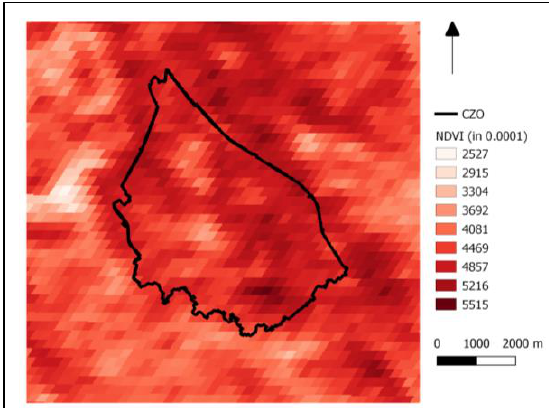
Figure 2.3. Normalised Differenced Vegetation Index